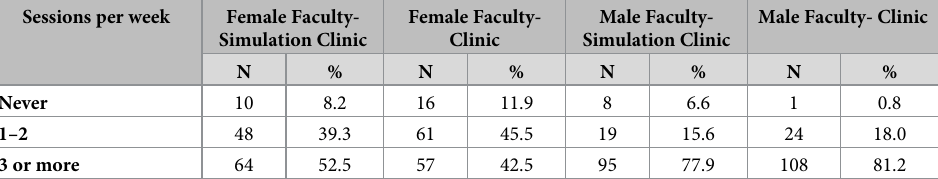
Table 2. Student’s exposure to faculty of different genders.